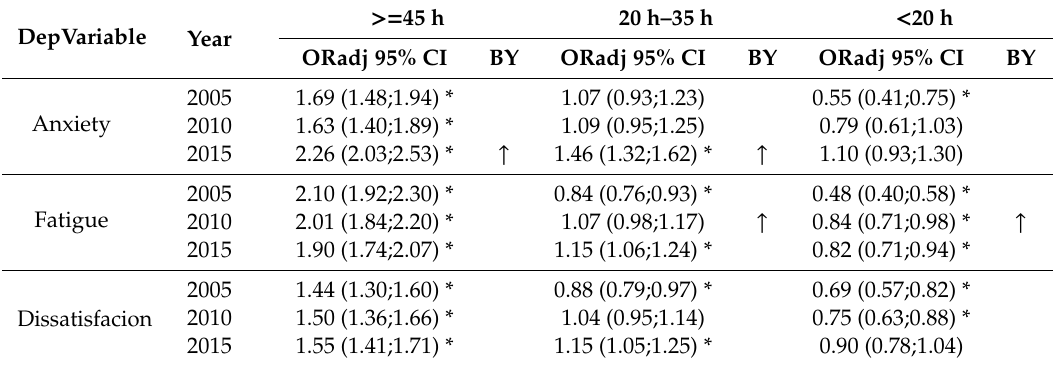
Table 3. Relationship between well-being and the number of weekly working hours in